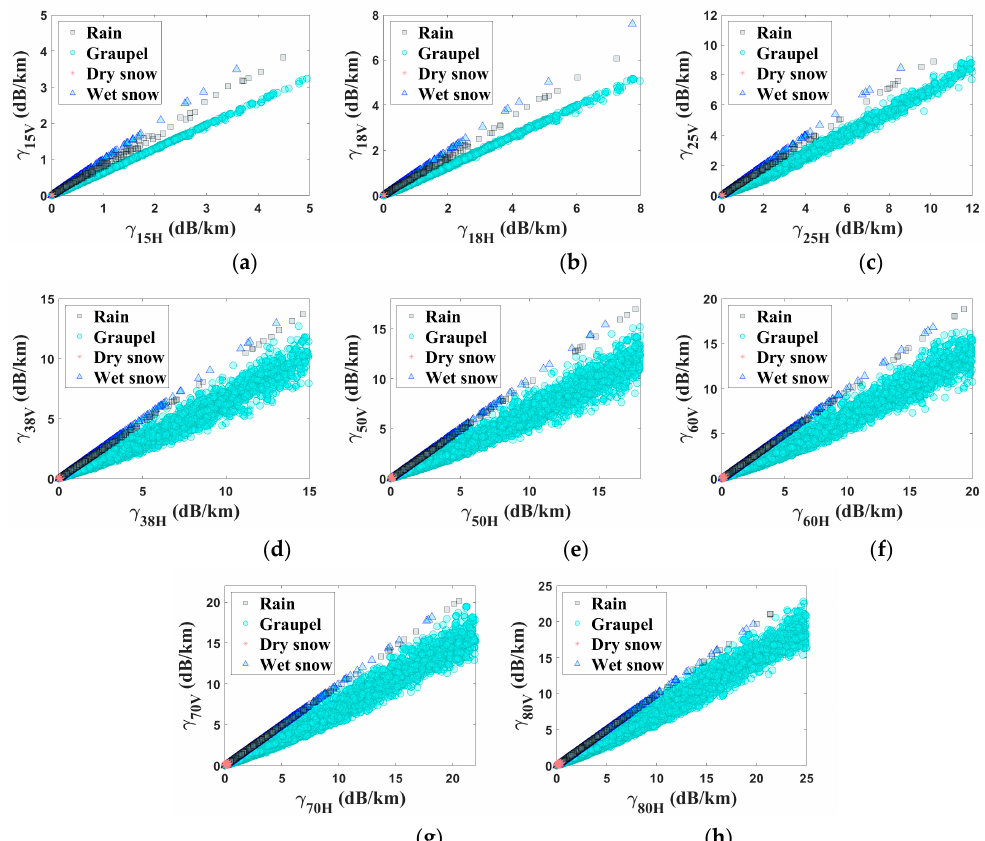
Figure 5. Scatter plots of horizontally and vertically polarized hydrometeor-induced attenuation pairs at frequencies of ( a ) 15 GHz, ( b ) 18 GHz, and ( c ) 25 GHz, ( d ) 38 GHz, ( e ) 50 GH, ( f ) 60 GHz, ( g ) 70 GHz, and ( h ) 80 GHz for rain (black square), graupel (cyan point), dry snow (red star), and wet snow (blue triangle).